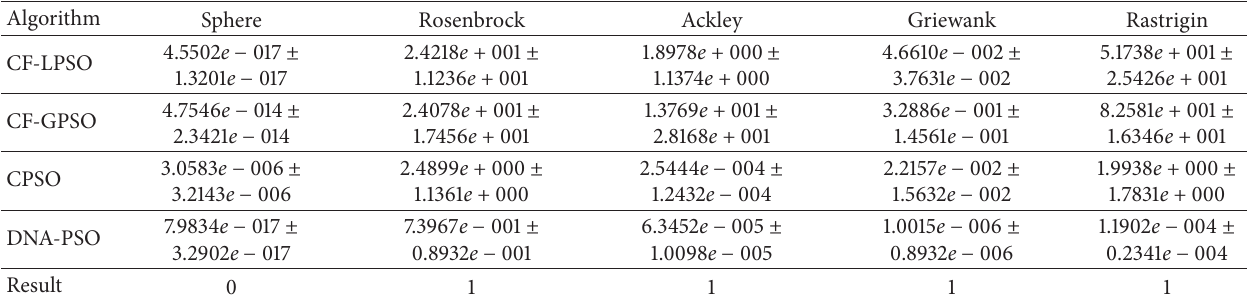
Table 1: Means and confidence interval for nonrotating function after 3 × 10 4 function